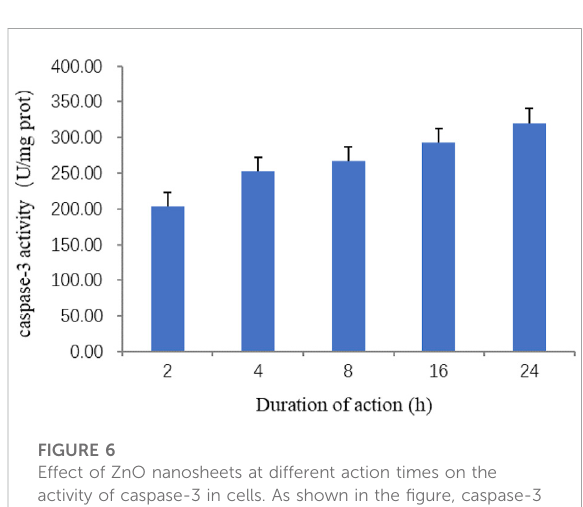
FIGURE 6 Effect of ZnO nanosheets at different action times on the activity of caspase-3 in cells. As shown in the fi gure, caspase-3